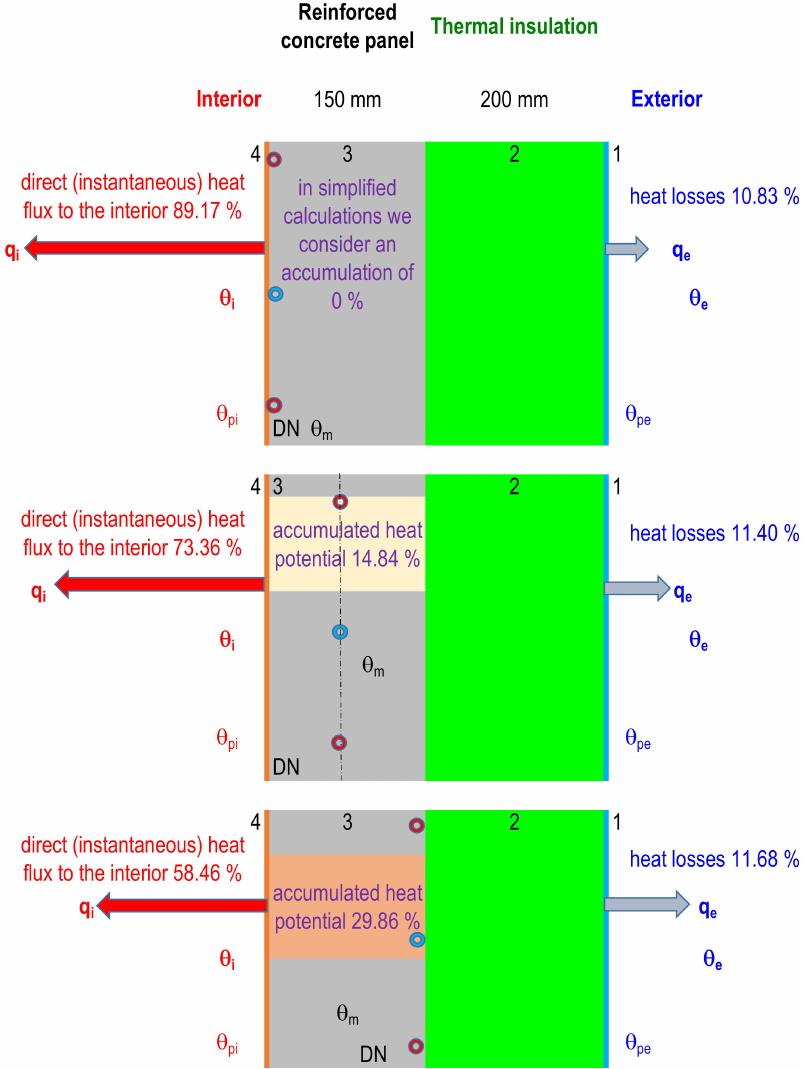
Figure 30. Heat flux analysis for the investigated variants of mathematical-physical perimeter reinforced concrete panels models. q i —heat flow towards the interior (W/m 2 ), q e —heat flow towards the exterior (W/m 2 ), θ i —internal calculation temperature ( ◦ C), θ e —outdoor calculation temperature ( ◦ C), θ pi —interior surface temperature ( ◦ C), θ pe —exterior surface temperature ( ◦ C), 1–4—layer number. [Author: Kal ú